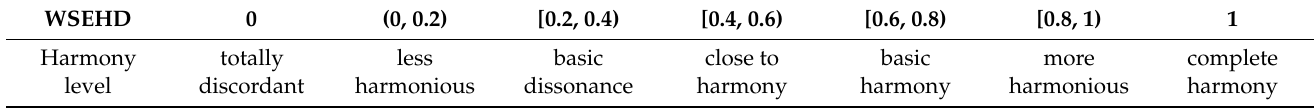
Table 2. Harmonious grading of water resources-economic society-ecological environment system.